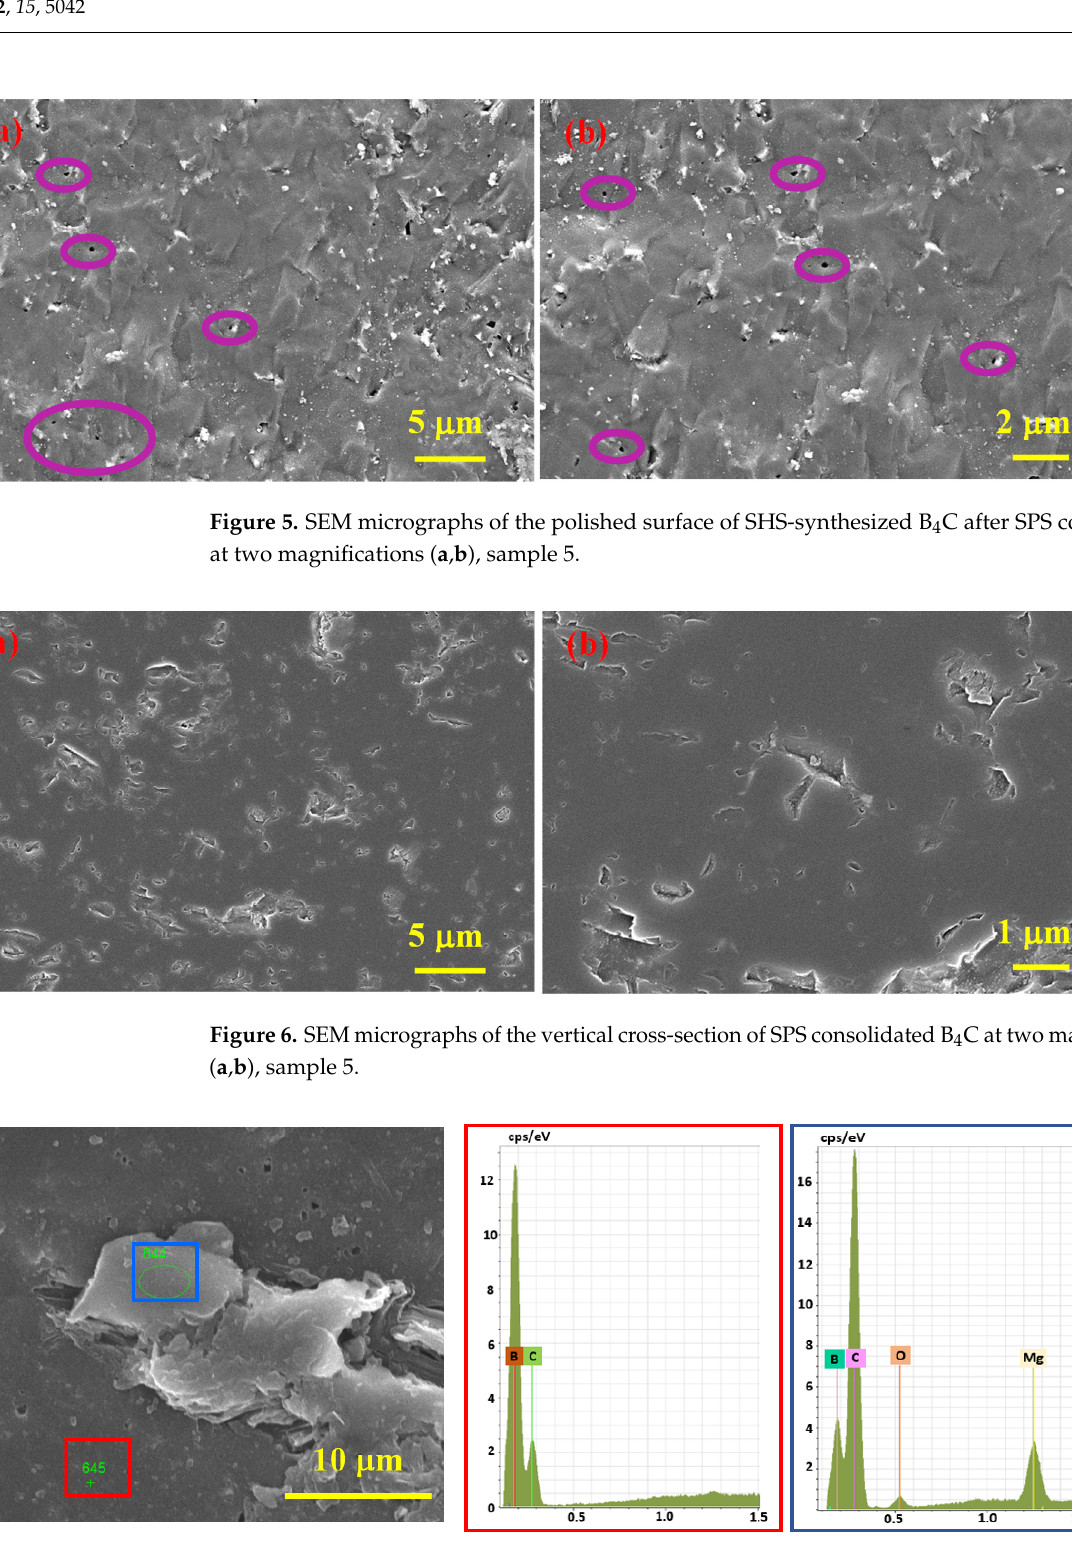
Figure 7. EDS analysis results of the cross-section of SPS-consolidated B 4 C, sample 5. Table 2. Consolidation conditions and properties of preliminary cold-pressed bulk boron carbide.